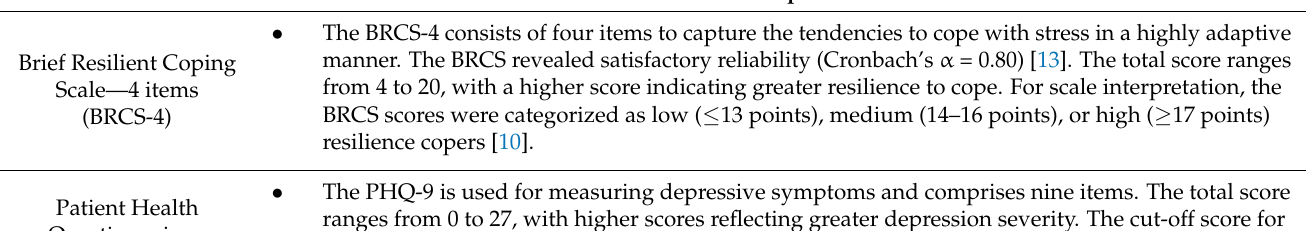
Table 1. Measurement tools of the survey.